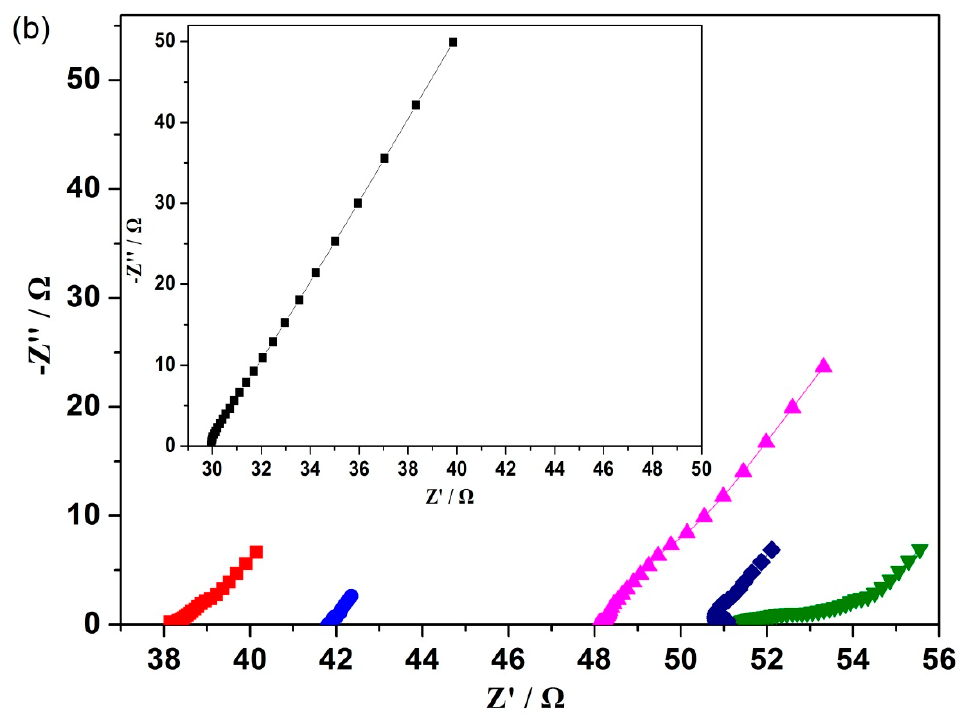
Figure 5. Nyquist plots of the (CNTs/PAH) n -deposited ITO electrode (n = 0, 3, 5, 7, 9, 12) after 25 h of chronoamperometry ( a ) and their higher magnifications of the high frequencies parts ( b ). The inset in panel (b) shows the magnified plot of the bare ITO electrode.